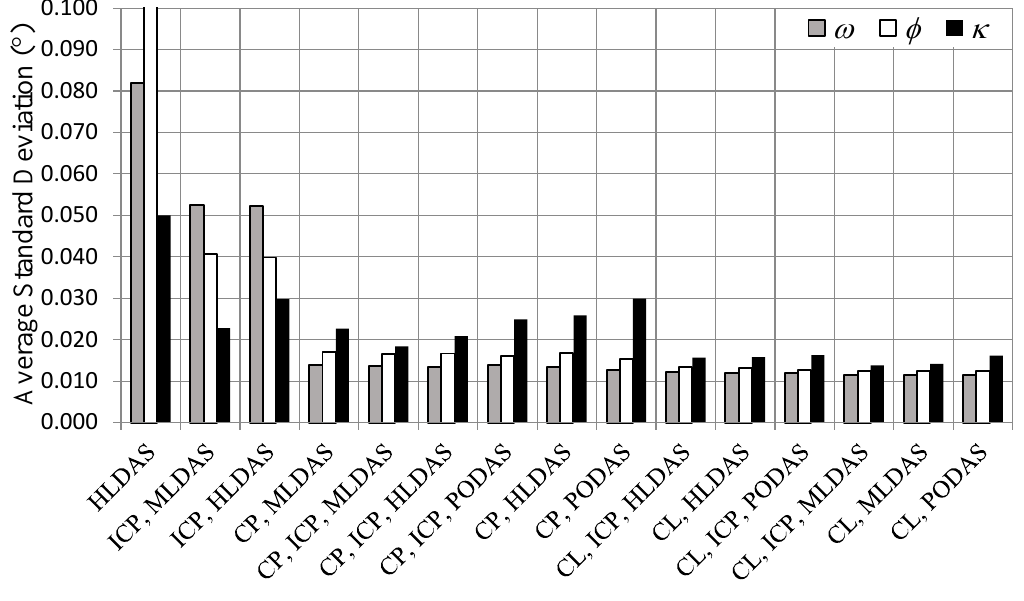
Figure 7. Average post-adjustment standard deviations for angular components of georeferencing parameters for the Site 2 dataset for configuration that do not use artificial targets. Note, σ = 0.18° for HLDAS is truncated. Standard deviations were extracted from ϕ the a posteriori covariance matrix shown in Equation